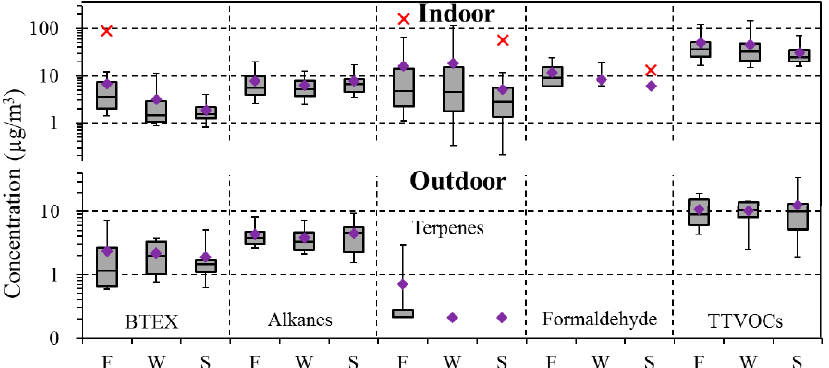
Figure 3. Box plots of BTEX, alkane, terpene, formaldehyde, and TTVOC concentrations indoors and outdoors in three seasons: fall (F), winter (W), and spring (S). Plots show 5th, 25th, 50th, 75th and 95th percentile concentrations. Diamond ( ♦ ) denotes mean. Asterisk (x) denotes outliers.